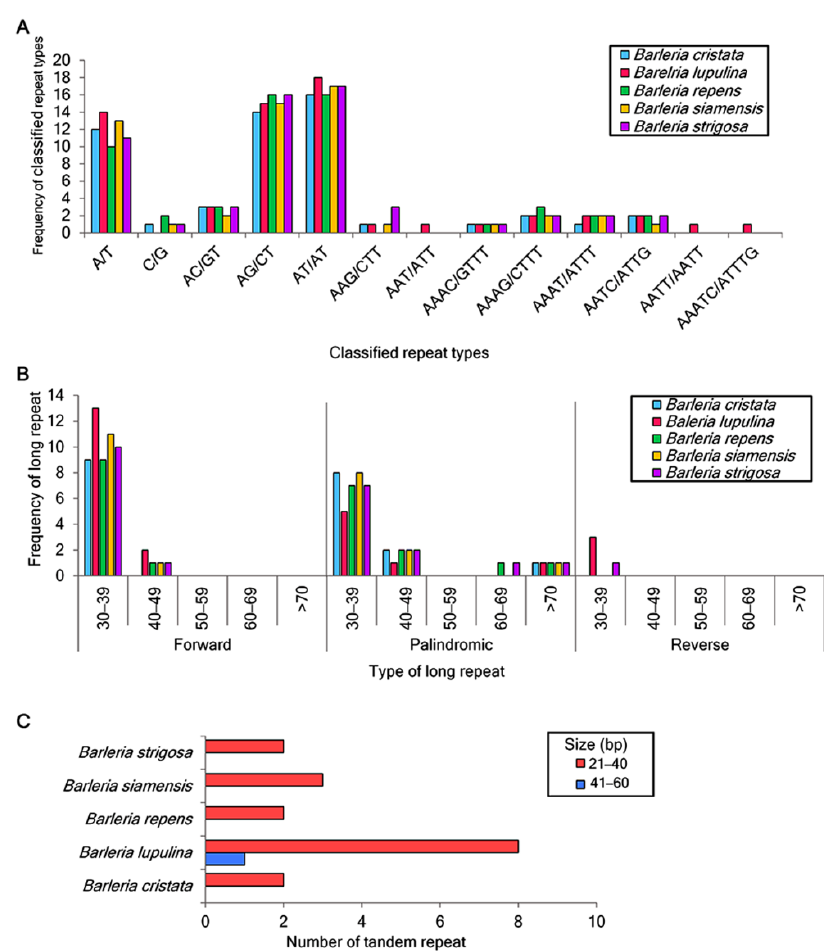
Figure 2. Repeated sequence analysis in the five Barleria species. ( A ) Number of classified SSR repeat units; ( B ) distribution and frequency of long repeats, including forward, palindromic, and reverse repeats; ( C ) number of tandem repeats.